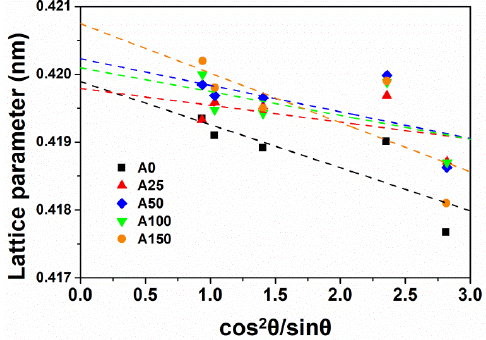
Figure 4. Lattice parameter determinations of the Batch A films.